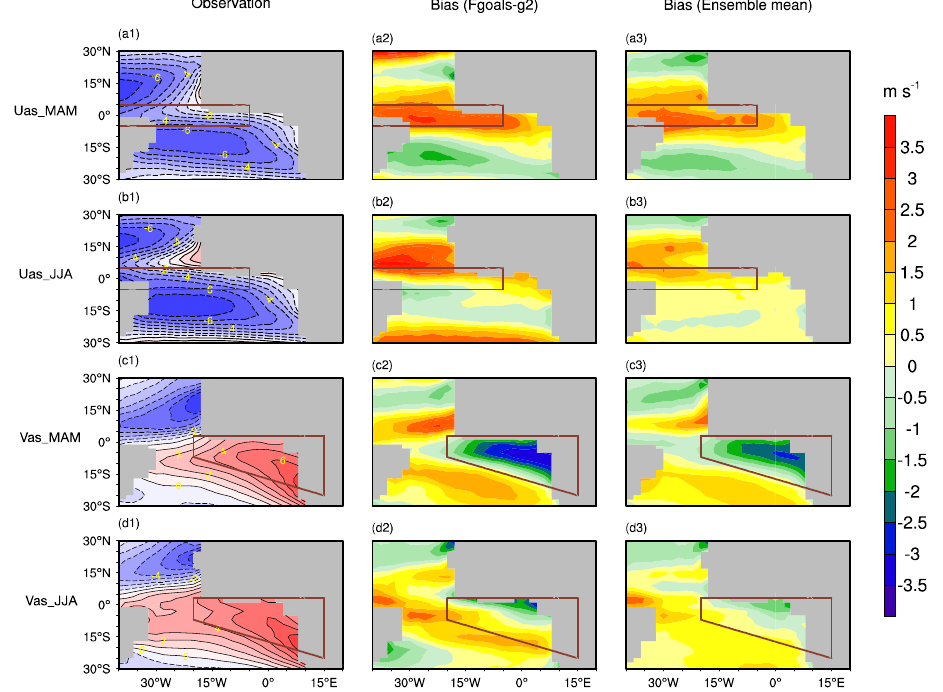
Figure 2. The seasonal mean surface zonal wind (uas; ( a , b ); unit: m s −1 ) and surface meridional wind (vas; ( c , d ); unit: m s −1 ) during 1979–2005. Panels ( a , c ) are for March–May (MAM); ( b , d ) for JJA. The first column shows the seasonal mean wind in the observational data, the second column shows the seasonal mean wind bias in the FGOALS-g2 model, and the third column shows the seasonal mean bias of the ensemble mean for 21 CCMs in CMIP5. The red box in ( a , b ) denotes the equator region, and in ( c , d ) denotes the ACT region and the region south of it.